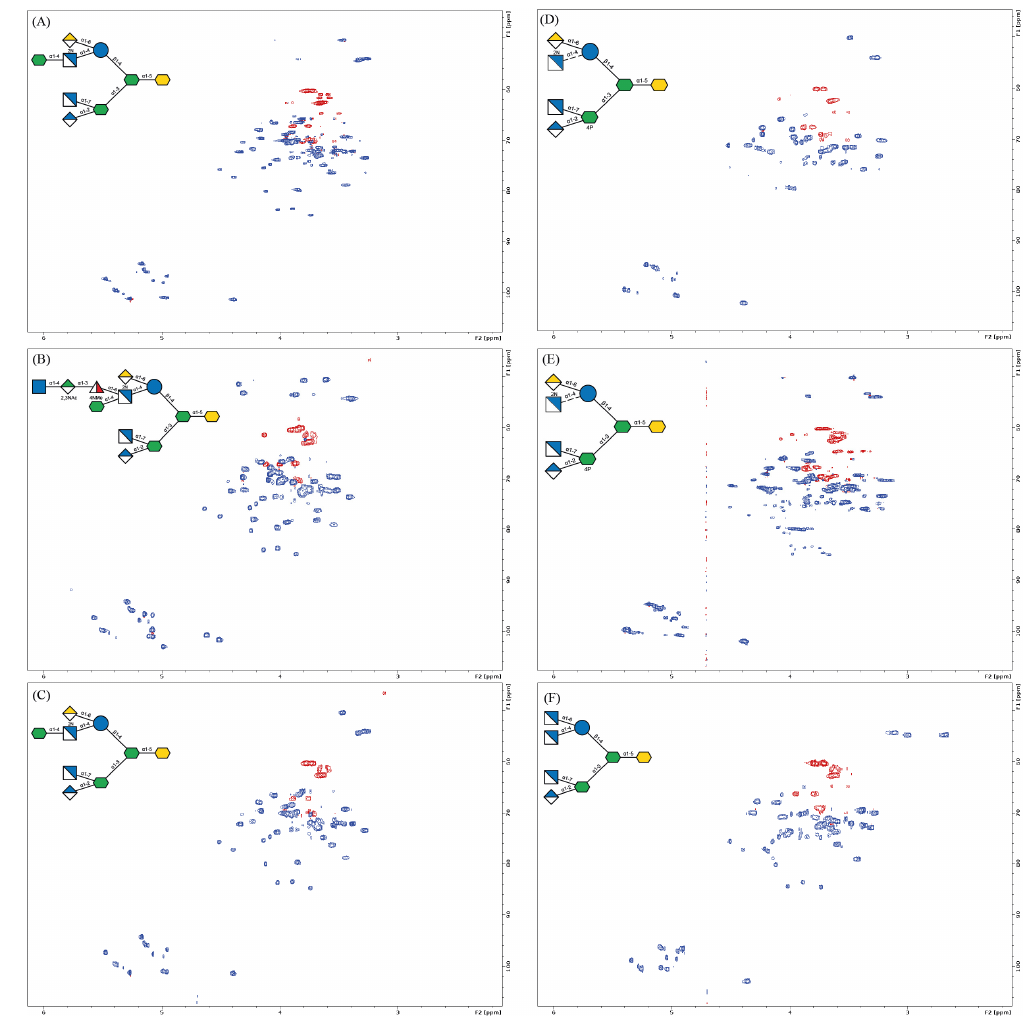
Figure 4. 1 H 13 C NMR HSQC-DEPT spectra of the oligosaccharides (OS) of Bordetellae ( A ) B. pertussis 606, ( B ) B. pertussis 186, ( C ) B. holmesii ATCC 51541, ( D ) B. bronchiseptica 530, ( E ) B. bronchiseptica 1943, and ( F ) B. parapertussis 529 and the symbolic representations of the deduced structures (insets). For the assigned versions of the spectra, refer to the Supplementary Materials, Figures